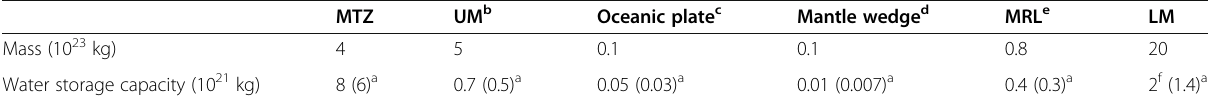
Table 1 Mass and the water storage capacity (the maximum water content that can be dissolved in minerals (or melts) in each